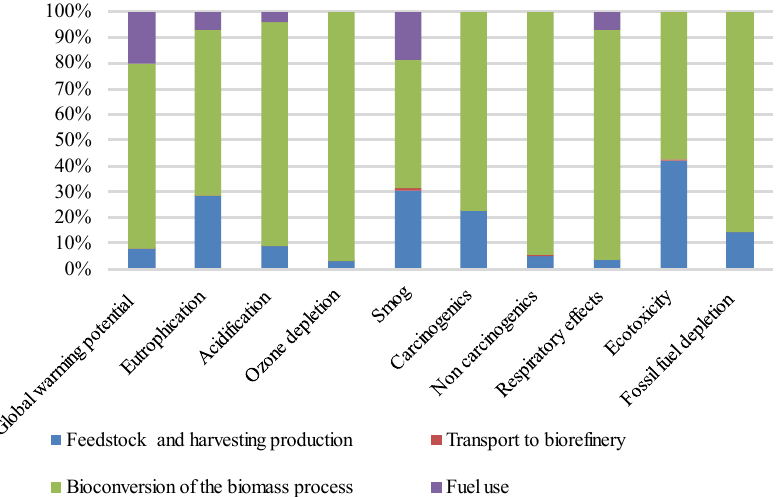
Figure 2. Mean contribution of each stage to the environmental impacts of bioethanol production.